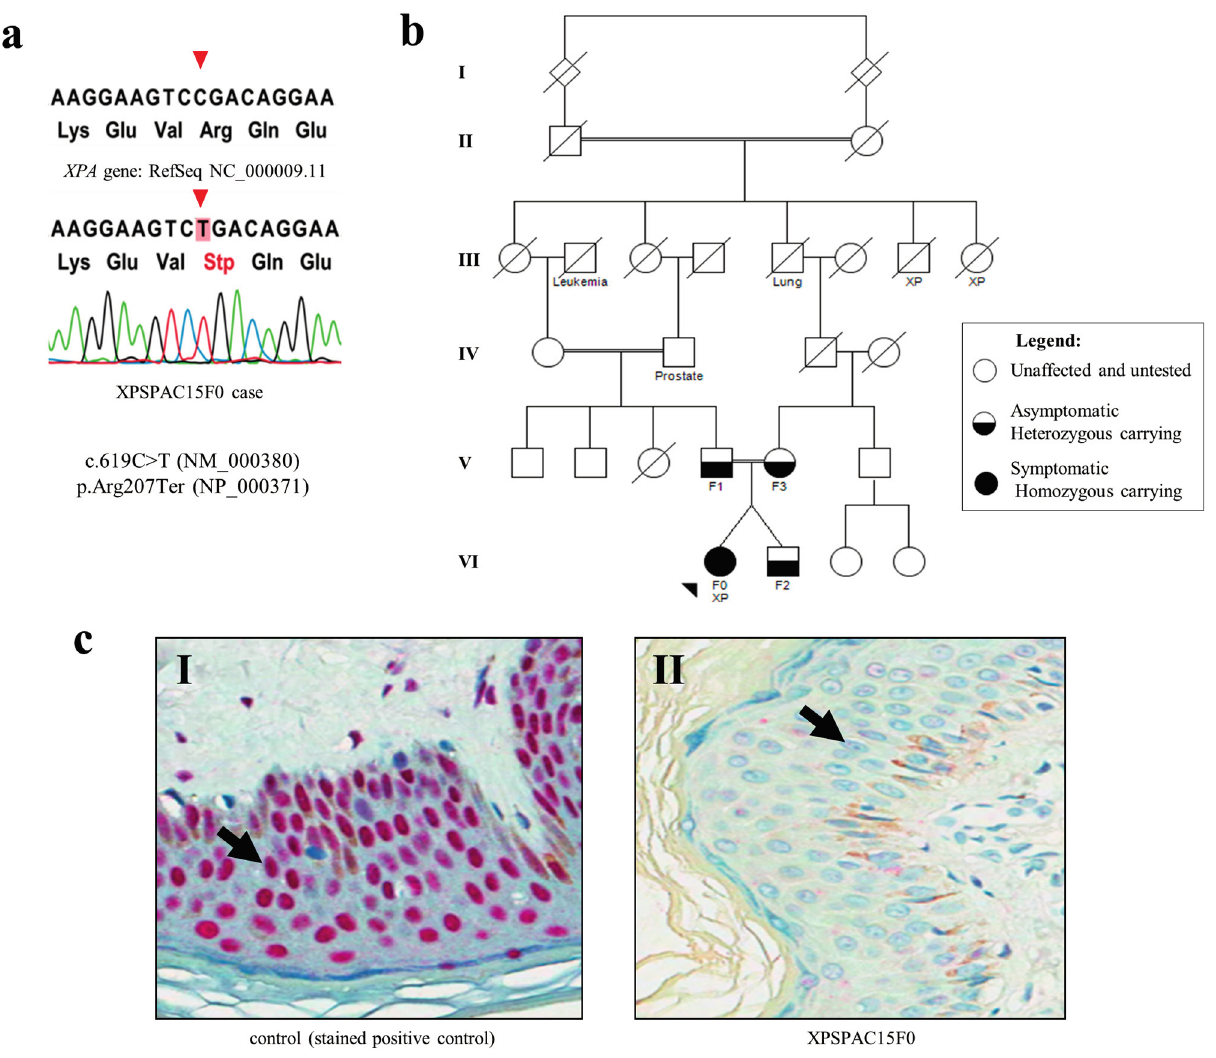
Figure 1. XPA pathogenic mutation and the absence of protein expression. ( a ) Electropherogram displaying the genomic DNA sequence for patient